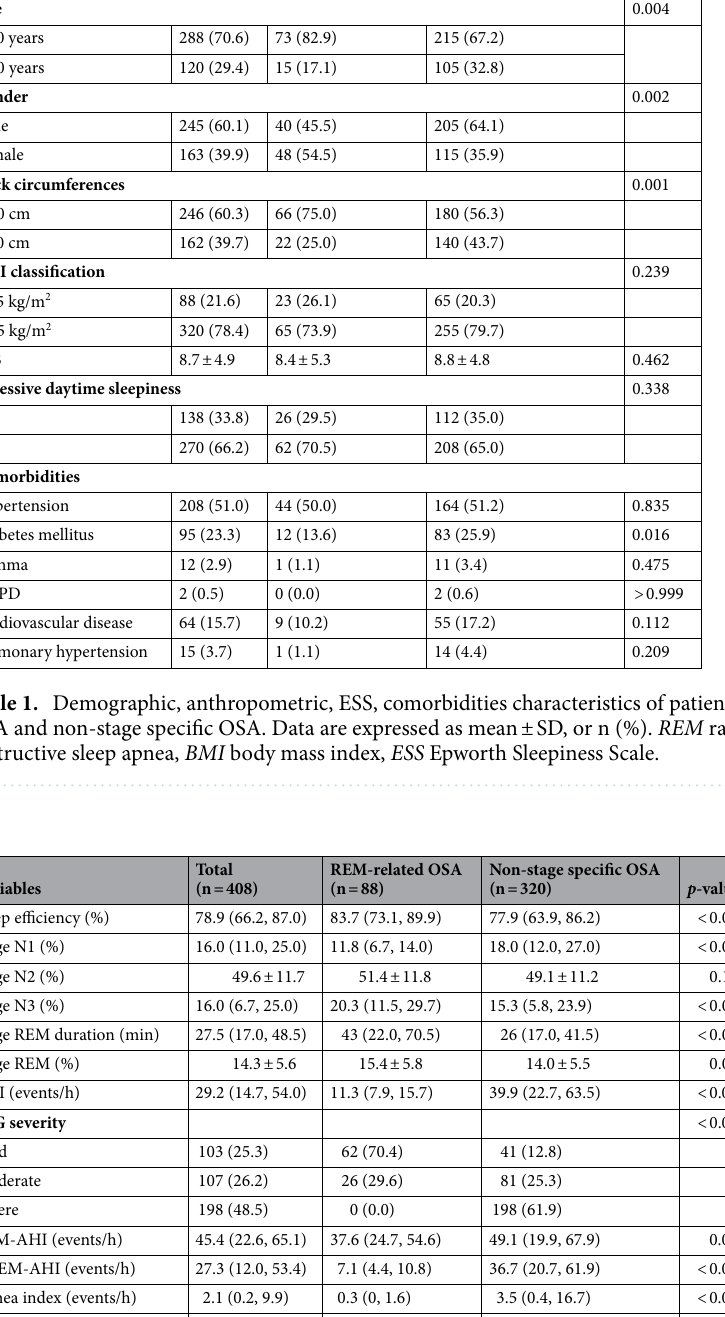
Table 2. Polysomnographic features of patients with REM-related OSA and non-stage specific OSA. Data are expressed as mean ± SD, median (IQR), or n (%). REM rapid eye movement, NREM non-rapid eye movement, OSA obstructive sleep apnea, AHI apnea–hypopnea index, SpO2 arterial oxygen saturation.